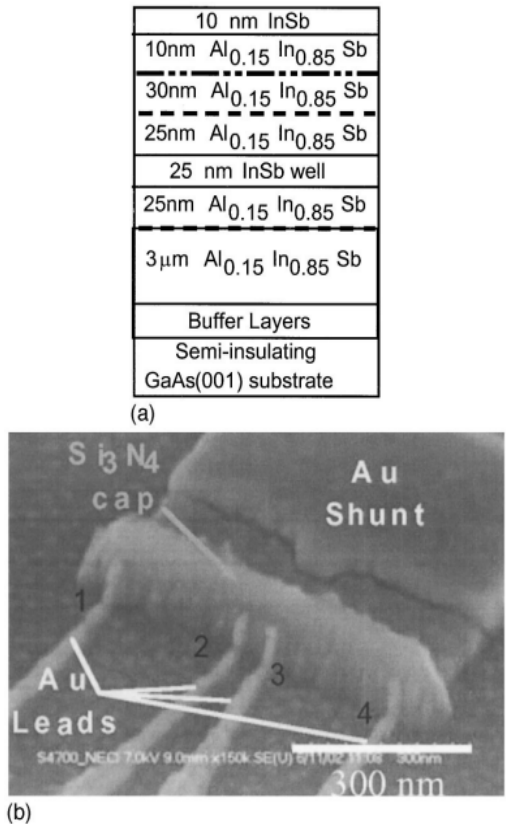
Figure 8. ( a ) InSb/In Al Sb heterostructure used to prepare the device shown in ( b ). The 1 − x x active region is the 25 nm thick InSb quantum well; ( b ) SEM photo of the mesoscopic bar-type EMR device. Reprinted with permission from [35]. Copyright 2003 American Vacuum